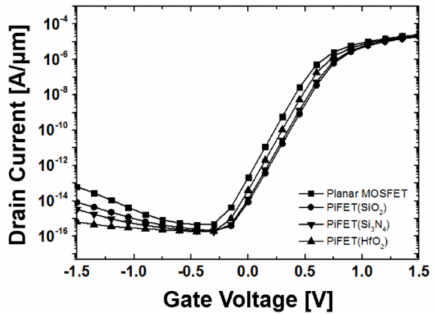
Figure 6. I DS -V GS indicating off-current characteristics for the planar MOSFET, the PiFET with a silicon film thickness of 15 nm, and the buried insulators of the SiO 2 , Si 3 N 4 , and HfO 2